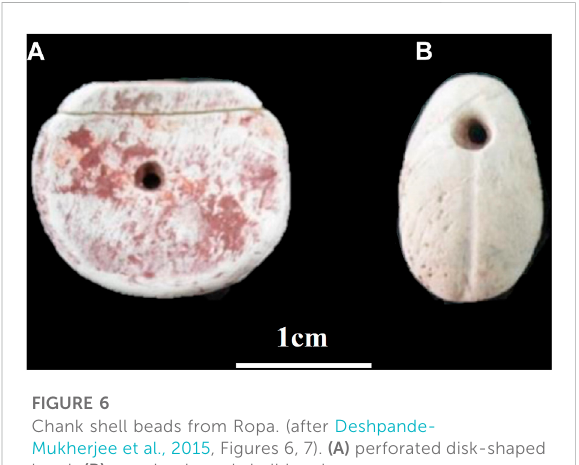
FIGURE 6 Chank shell beads from Ropa. (after Deshpande- Mukherjee et al., 2015, Figures 6, 7). (A) perforated disk-shaped bead; (B) cowrie-shaped shell